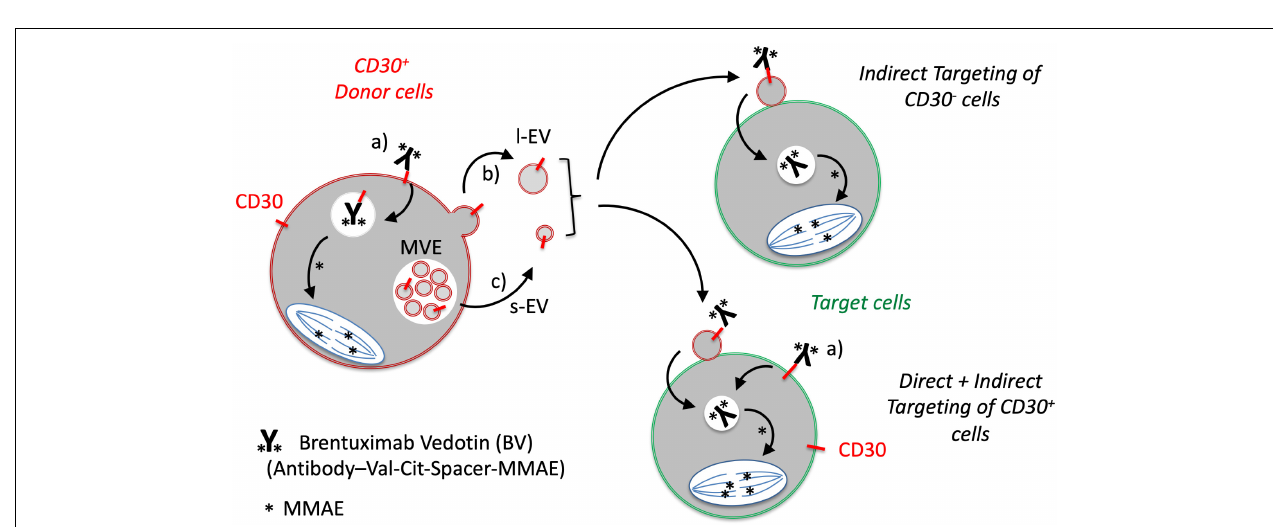
FIGURE 3 | Viability assay of Karpas 422. Viability assay of Karpas 422 ± EVs from L540 cells with the addition of BV in different concentrations 1, 3, and 10 µ g/mL (from left to right); ± the inhibitory anti-CD30 antibody HeFi-1. The percentage of living cells was analyzed by flow cytometry using the propidium iodide (PI) staining. For the statistical analysis the Mann–Whitney test was used.